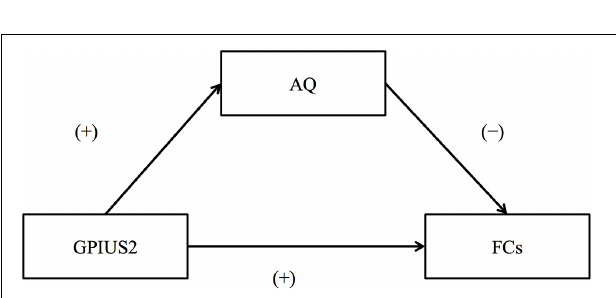
FIGURE 2 | Schematic representation of the relationship among internet use, autistic traits, and functional connectivity. (+) and (–) mean the direction of standardized coefficients between GPIUS2 and FC, GPIUS2 and AQ, and AQ and FC, respectively. GPIUS2, Generalized Problematic Internet Use Scale 2; AQ, Autism Spectrum Quotient; FC, functional connectivity correlated with GPIUS2